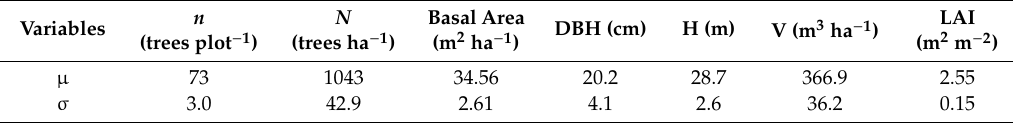
Table 2. Dendrometric variables in the 10-year-old Eucalyptus urophylla × Eucalyptus globulus stand.